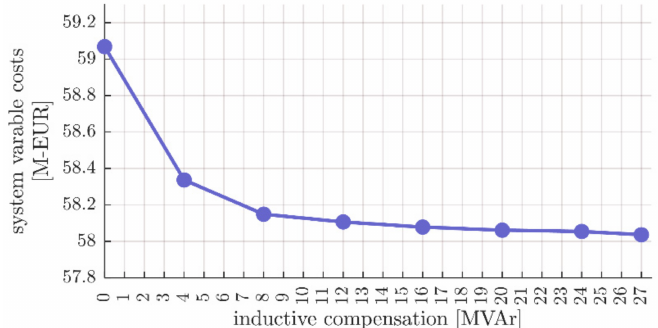
Figure 9. Reduction of system annual variable operating cost as a function of the installed reactor capacity.